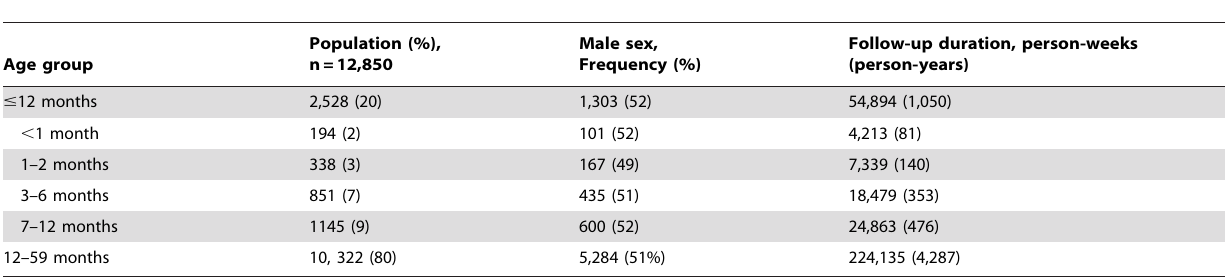
Table 1 . Age distribution and follow-up duration of children aged , 5 years in Matlab, Bangladesh, June–October 2010 .